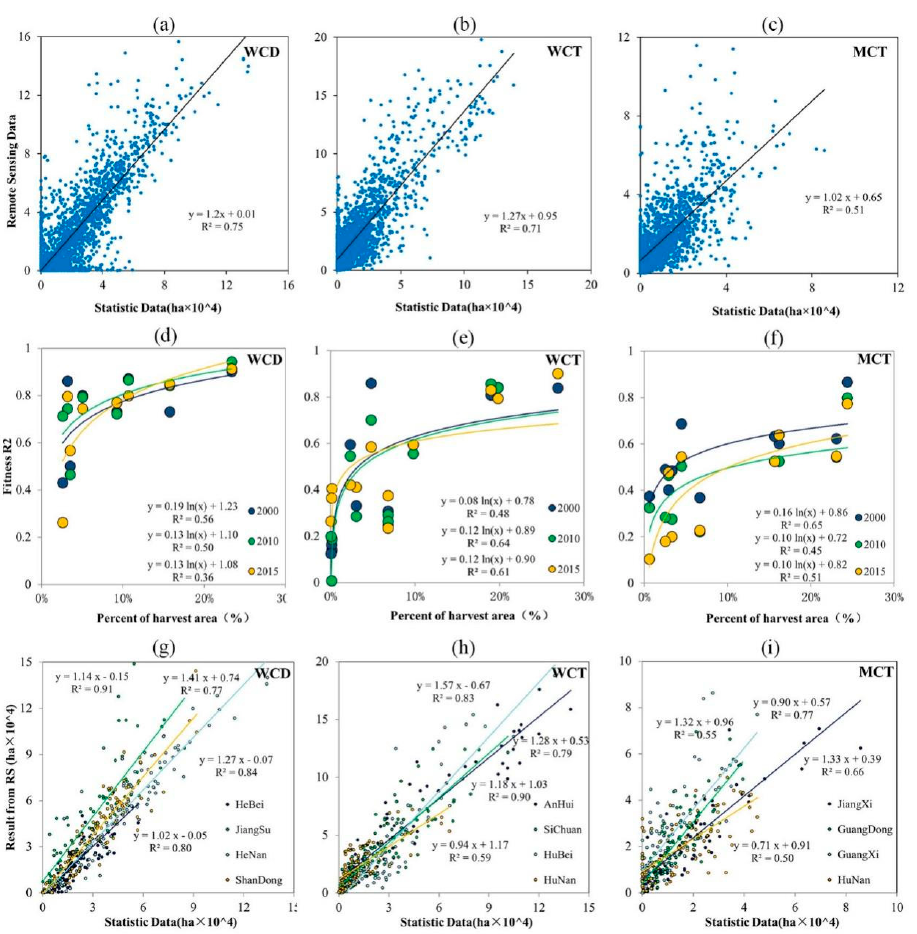
Figure 4. Comparison of remote sensing results with statistical data. WCD: winter crops in potentially double cropped areas; WCT: winter crops in potentially triple cropped areas; MCT: main season crops in triple cropped areas. ( a – c ): comparison at the county level for the whole country; ( d – f ): plots of fitness, represented by R 2 , against the percent of harvest areas of the crops of concern at the province level; ( g – i ): comparisons at the county level for the first four provinces with the highest harvest areas of the crops of concern.